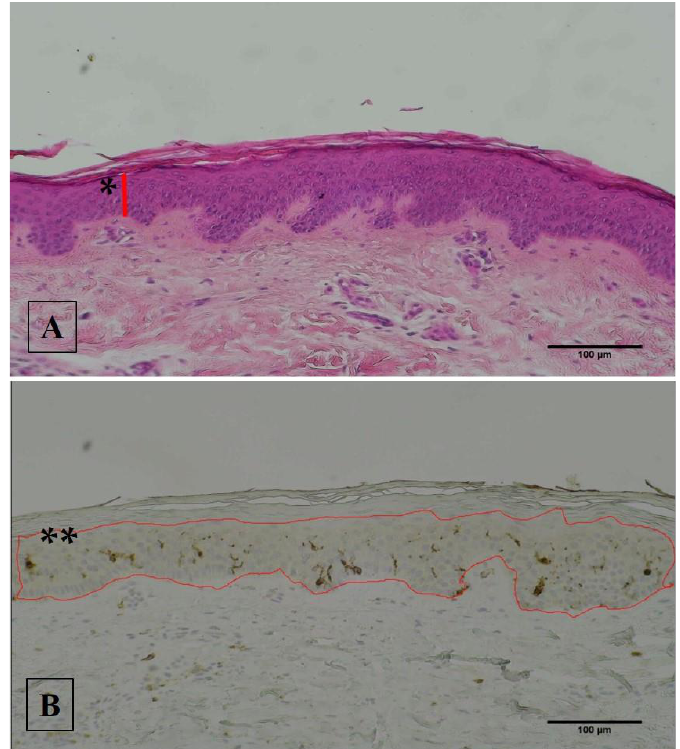
Figure 1. Histological sections of 5 µm thickness were collected and stained by ( A ) standard Hematoxilin-Eosin (H-E) stain protocol and ( B ) with a standard immunohistochemical procedure to analyze CD1a, a specific marker of Langerhans Cells (LCs); * = the distance between the outermost surface of the epidermis (excluding the stratum corneum ) and the dermo – epidermal junction; ** = outline of total area of epidermis.